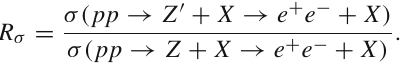
and corresponding limit from LHC. Right pattern: allowed parameter space e − L τ Table 5 Branching ratios of charge scalar η ±